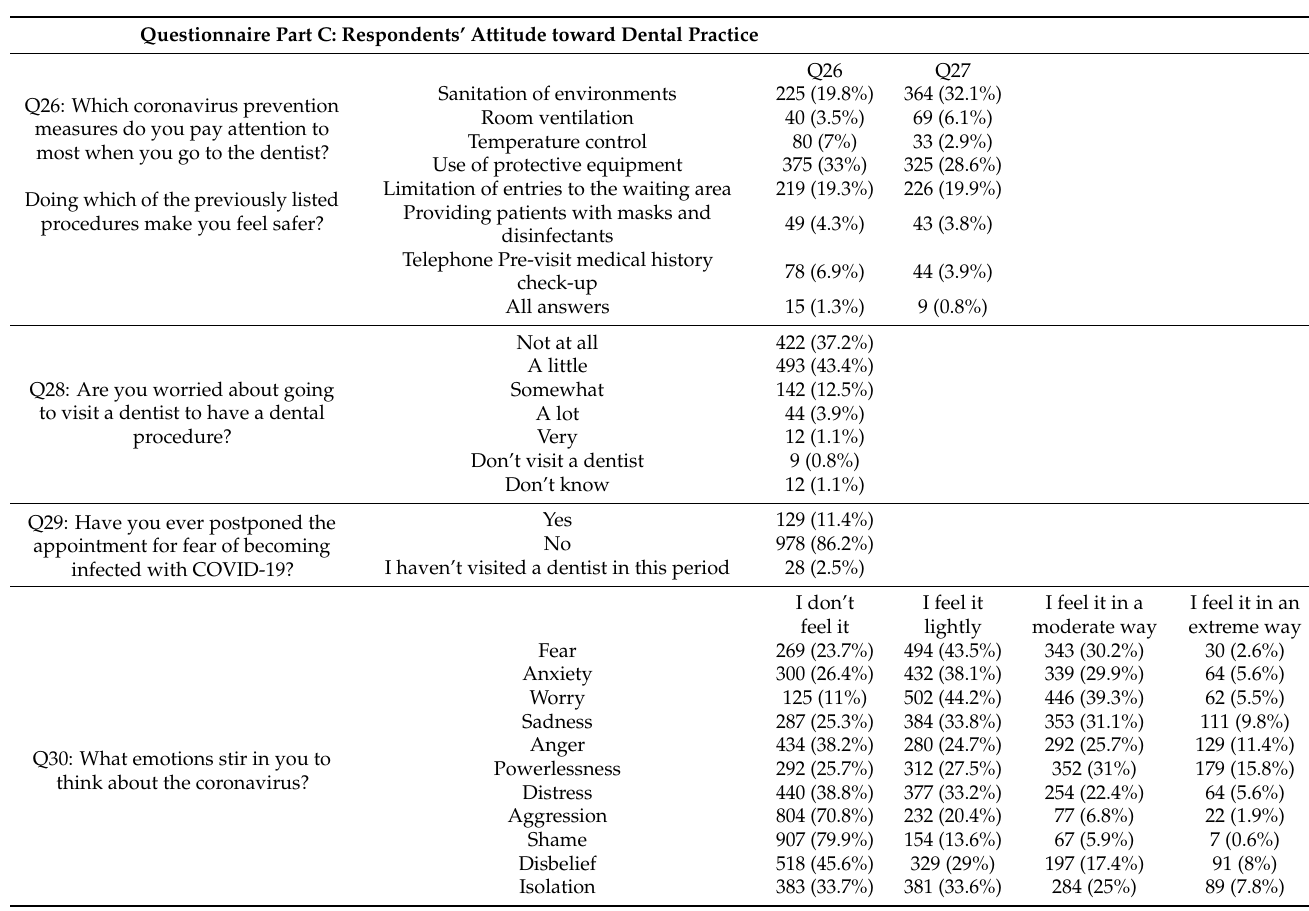
Table 3. Questionnaire Part C—Respondents’ Attitude toward Dental